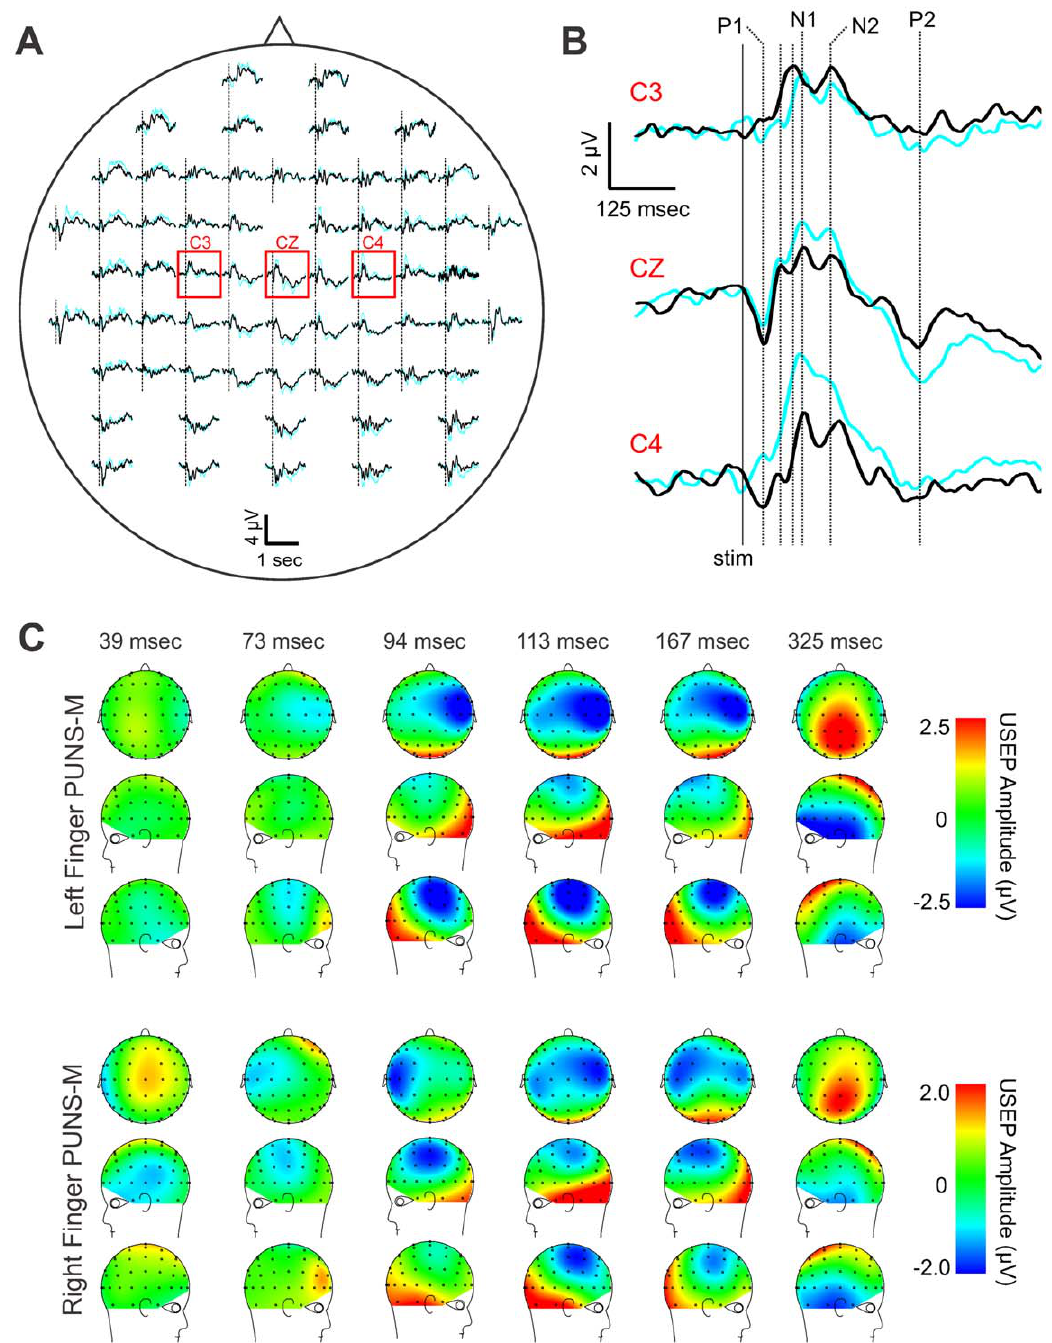
Figure 2. Pulsed ultrasonic neurostimulation elicits ultrasound-evoked potentials. ( A ) Grand average of ultrasound-evoked potentials (USEPs) recorded from five subjects using a 64 channel EEG in response to right ( black traces ) and left ( cyan traces ) fingertip stimulation using a PUNS- M waveform are shown in a top-view of the whole-head. The channels indicated by the red square are shown at a higher gain in B . The vertical dashed lines represent the onset of stimulation and the EEG traces illustrate a time period from 100 msec pre-stimulus to 1000 msec post-stimulus. ( B ) Grand average USEPs from electrode sites C3, CZ, and C4 shown in A , but at a higher amplitude and temporal gain. The vertical dotted lines show time points of interest for which average voltage maps are shown in C and labels (P1, N1, N2, and P2) indicate potentials of interest. ( C ) Topographic voltage maps from time-points corresponding to vertical dotted lines in B illustrate grand average USEPs obtained in response to PUNS-M stimulation of the left ( top ) and right ( bottom ) fingers. doi:10.1371/journal.pone.0051177.g002 amplitudes at ipsilateral electrode sites were 2 3.24 6 1.45 m V for amplitudes at contralateral electrode sites were 2 2.74 6 1.81 m V for right finger stimulation and 2 4.08 6 1.85 m V for left finger right finger stimulation and 2 2.82 6 1.73 m V for left finger stimulation using PUNS-M. Conversely the mean N1 USEP stimulation with PUNS-M.